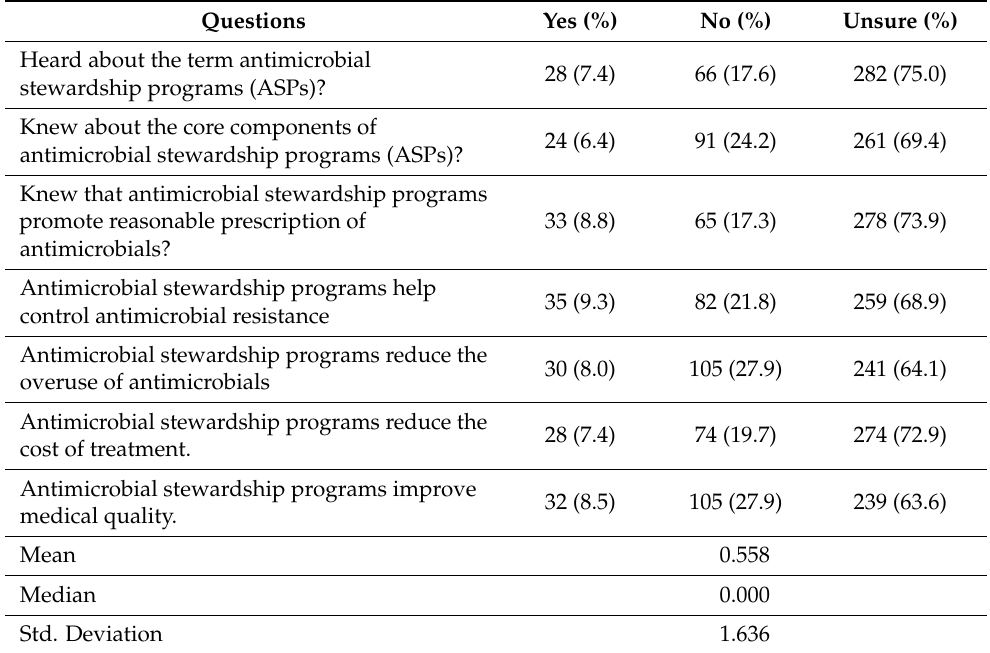
Table 5. Awareness about the antimicrobial stewardship programs